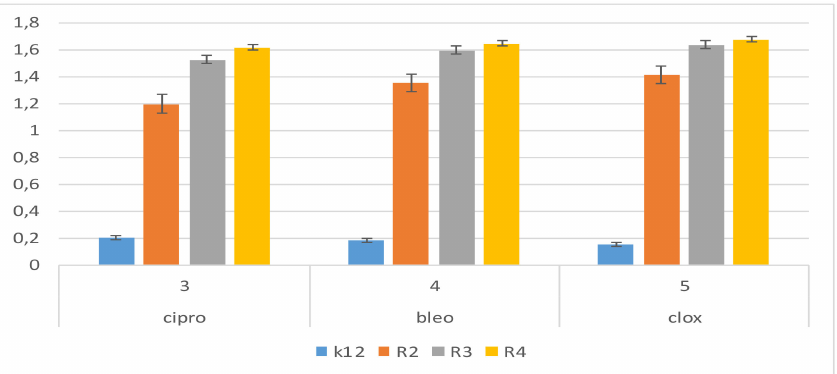
Figure 7. Examples of MIC with model bacterial strains K12, R2, R3, and R4 for studying antibiotics ciprofloxacin, bleomycin, and mechanism. The x -axis features antibiotics used sequentially. The y -axis features the MIC value in µ g/mL − 1 .